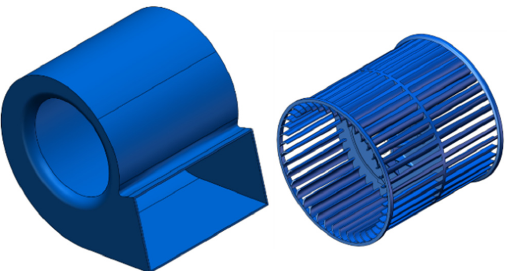
Figure 1. Physical model of multi-blade centrifugal fan.